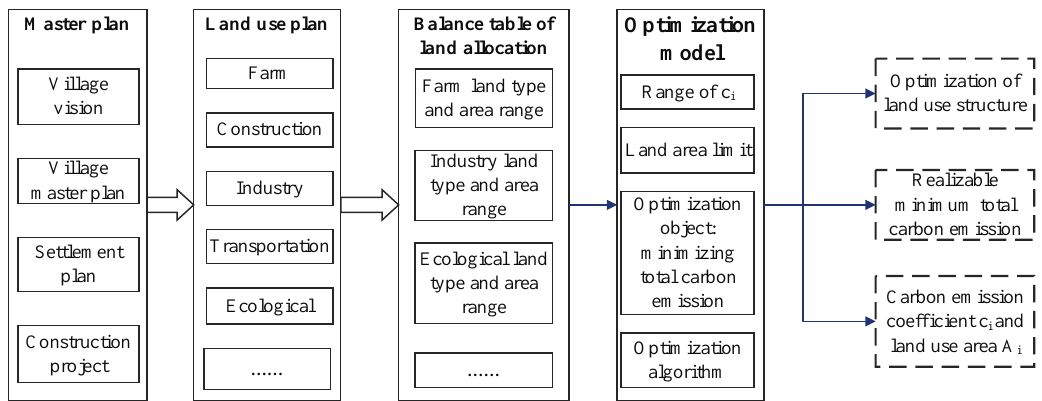
Figure 2. First optimization of land-use structure.